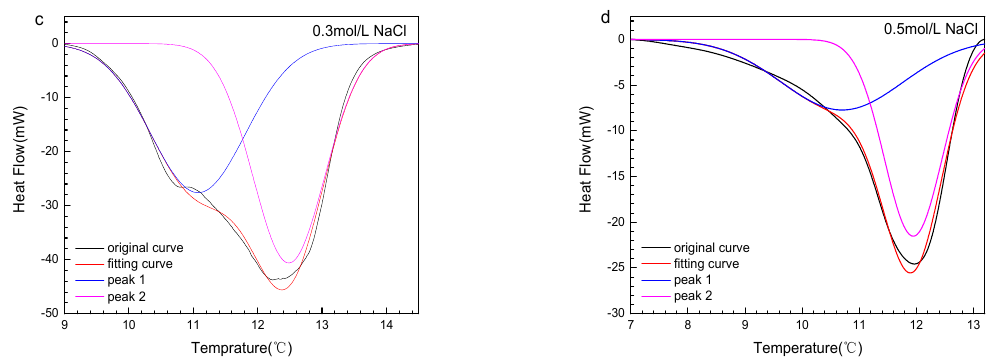
Figure 9. Thermograms of methane hydrate dissociation in montmorillonite samples: ( a ) sample 1, ( b ) samples 2, ( c ) sample 3, and ( d ) sample 4.